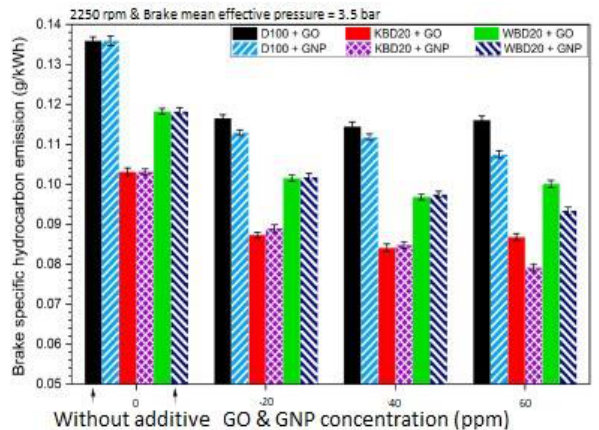
Fig. 12. Variation of HC emission depending on the concentration GO